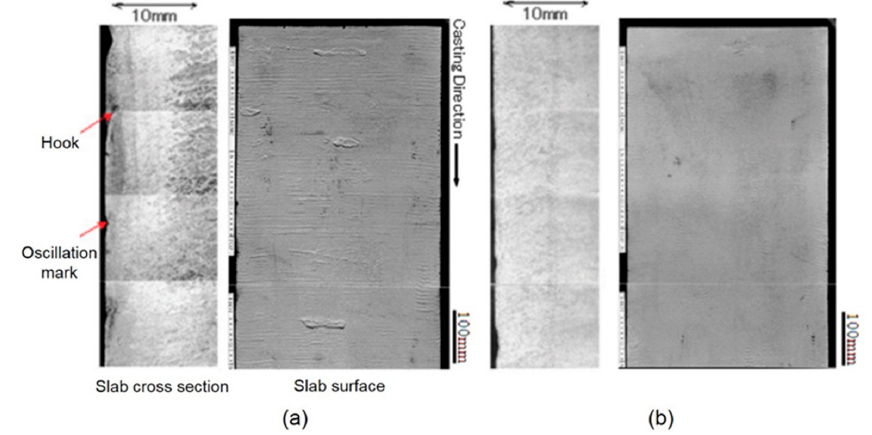
Figure 20. Oscillation marks and hooks in steel slabs ( a ) without and ( b ) with electromagnetic casting (EMC)